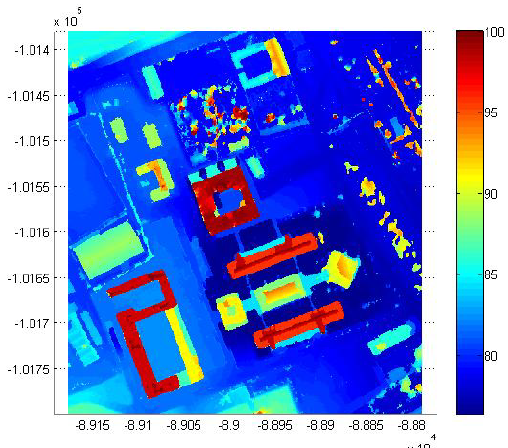
Figure 2. LiDAR data set classified according to the height